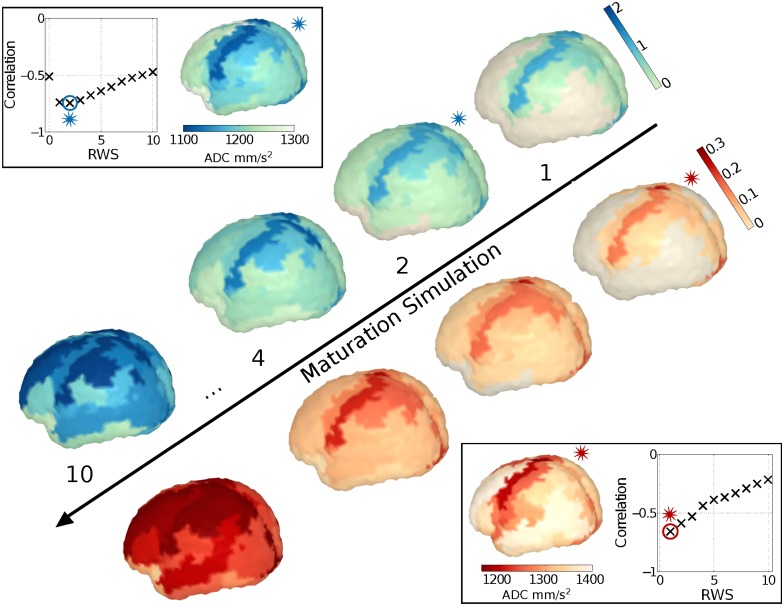
Modelled maturation scores projected on a standard brain surface for four representative simulated time points (RWSs): ROI in blue (top), connections in red (bottom).Box: Experimental data (ADC [10−6 mm/s2]) on brain surface and Pearson’s correlations with modelled maturation scores for RWS 1–10. The RWS with the best correlation is represented by a star.